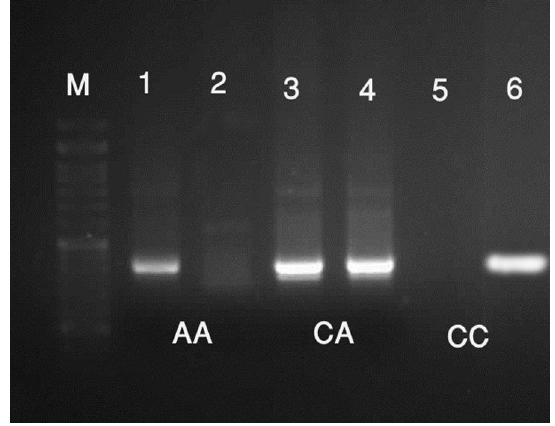
Fig. 2 Agarose gel electrophoresis for detection of rs3761548 polymorphism. Lane (M): molecular weight marker, lanes 1,2 AA genotype; lanes 3, 4: AC genotype and lanes 5,6: CC